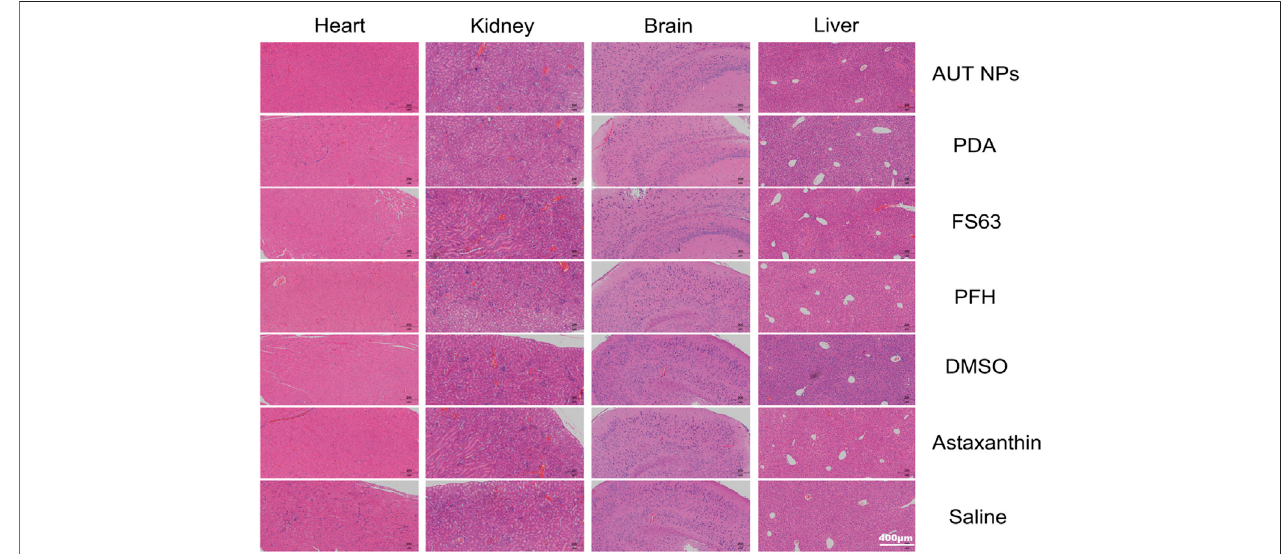
FIGURE 7 | The organs histopathological assay of AUT NPs in acute toxicity.